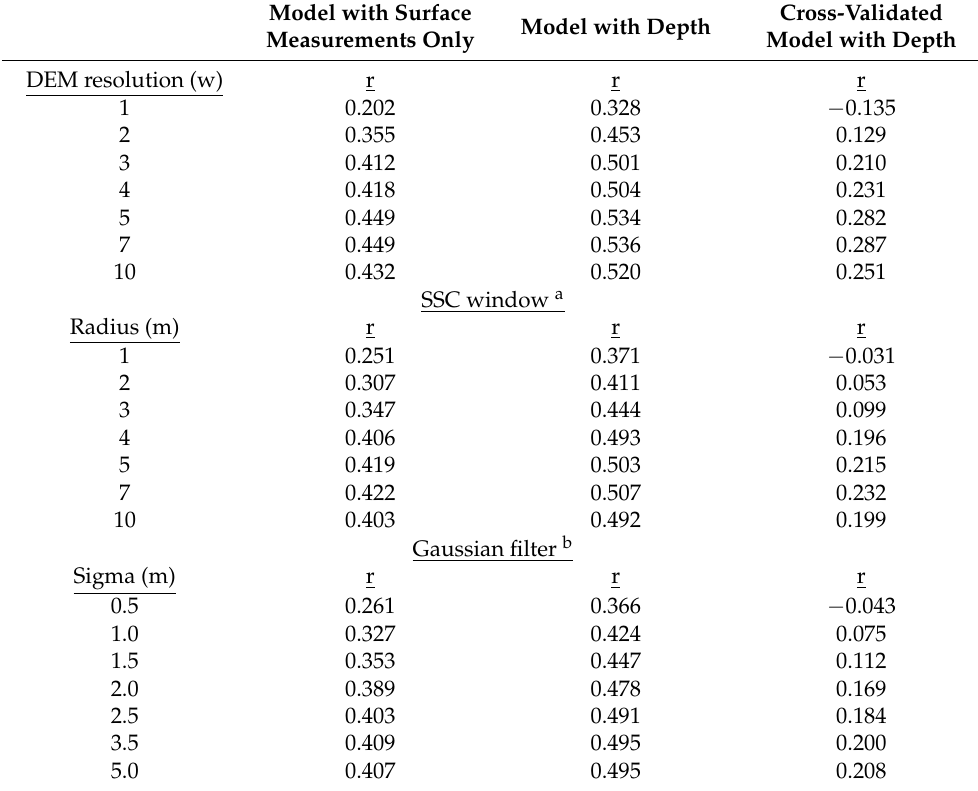
Table 1. Pearson correlation coefficients between average TWI from all tested algorithms and observed monthly moisture volumetric water content average values. The coefficients shown are the mean r values of TWI models with measured monthly mean soil moisture. Cross-Validated Model with Surface Model with Depth Model with Depth Measurements Only DEM resolution (w) r r r 0.202